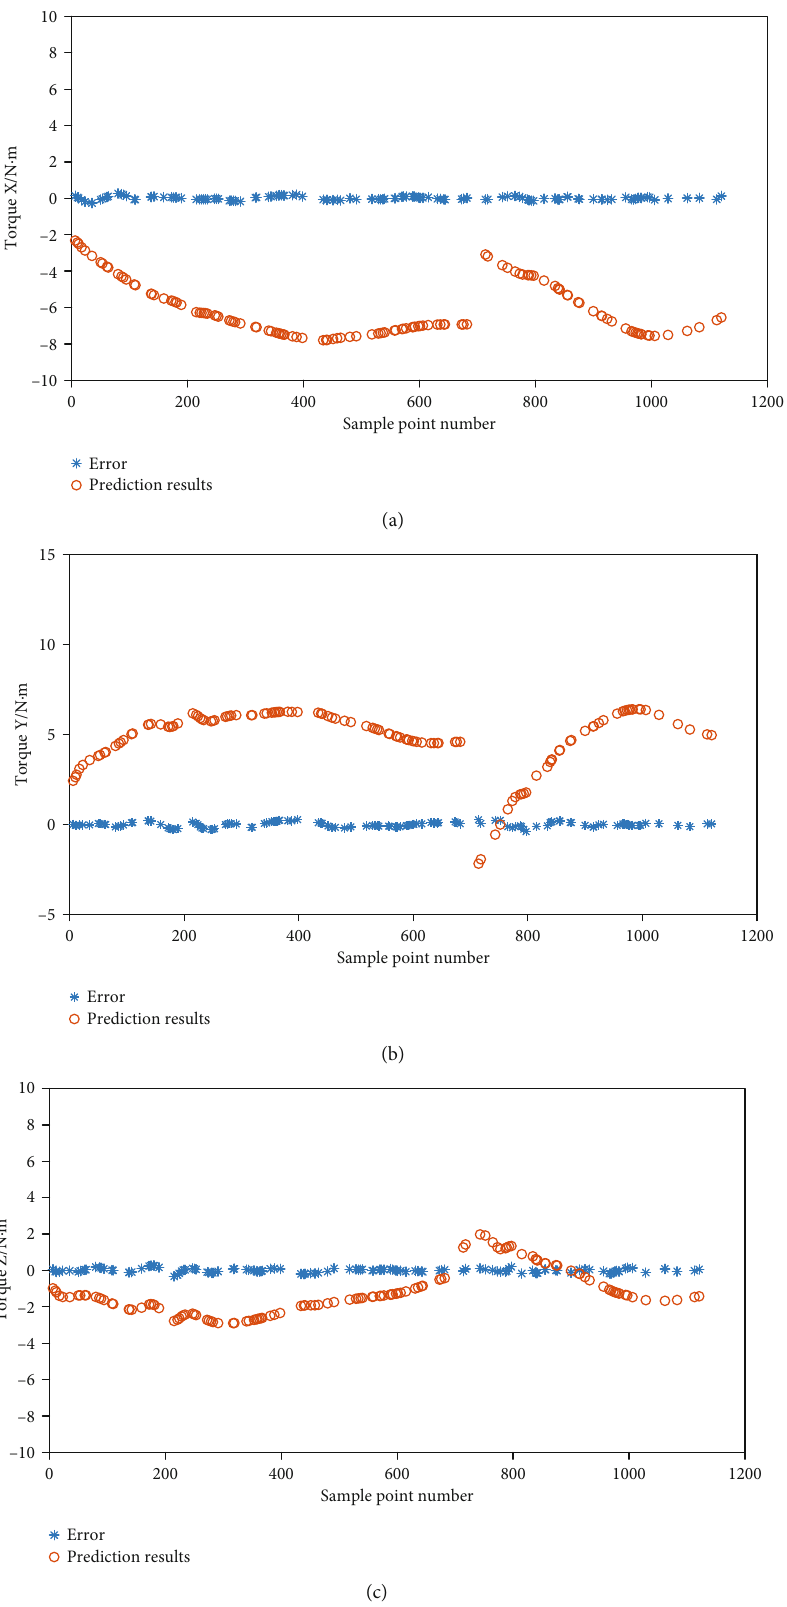
Figure 10: Assessment results and errors in each